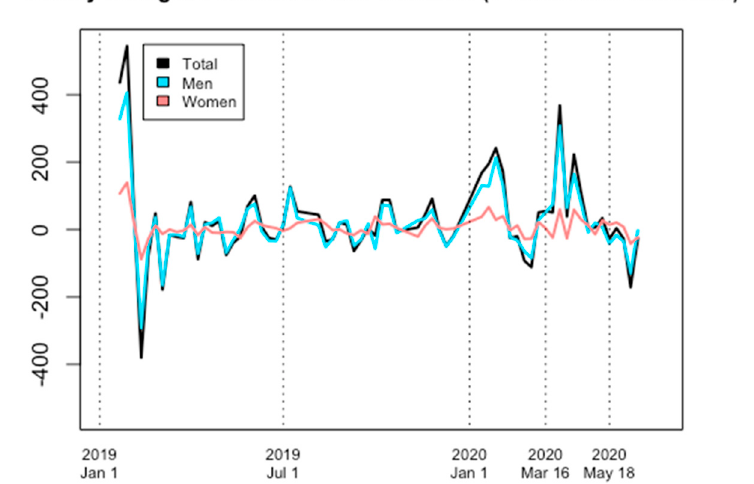
Figure 2. Weekly change in number of individuals self-excluded for a one-month interval, 1